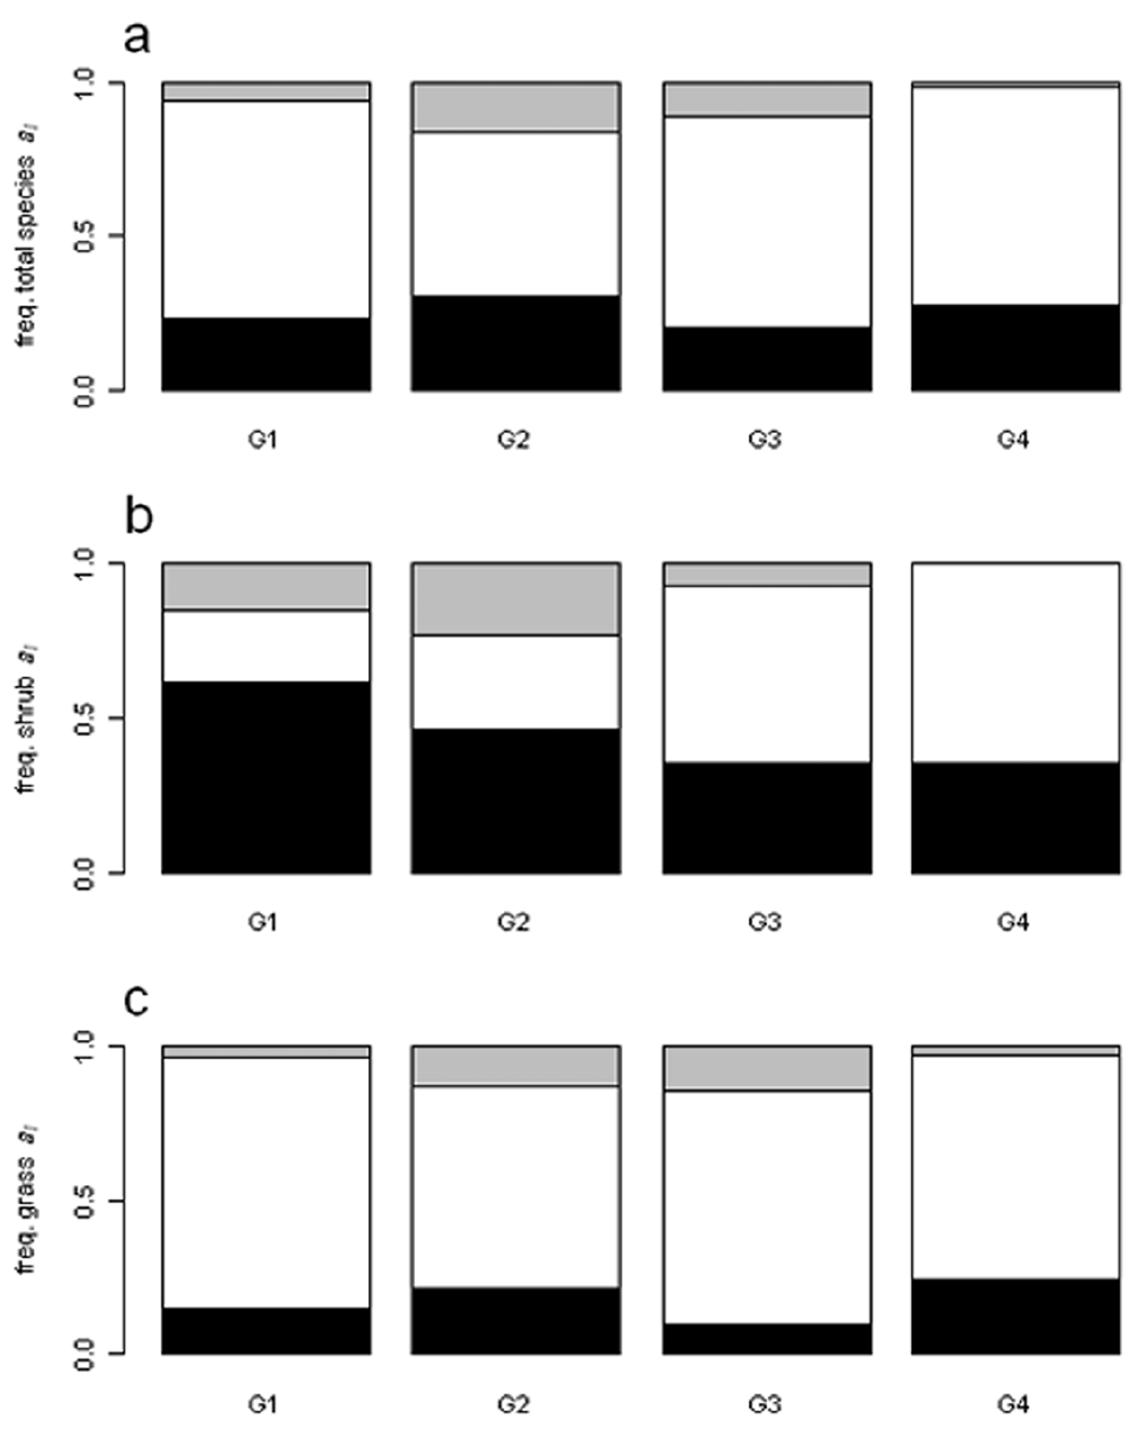
Figure 2. Relative number of species for each type of association. a, proportion of species with each type of association; b,proportion of shrubs with each type of association; c, proportion of grasses with each type of association; G1 to G4 are the sampling sites. Associations are classified as negative (black area), neutral (white area) or positive (grey area) depending on the relationship between a i value and the expected distribution. Only species that could allow distinguishing negative from neutral associations were